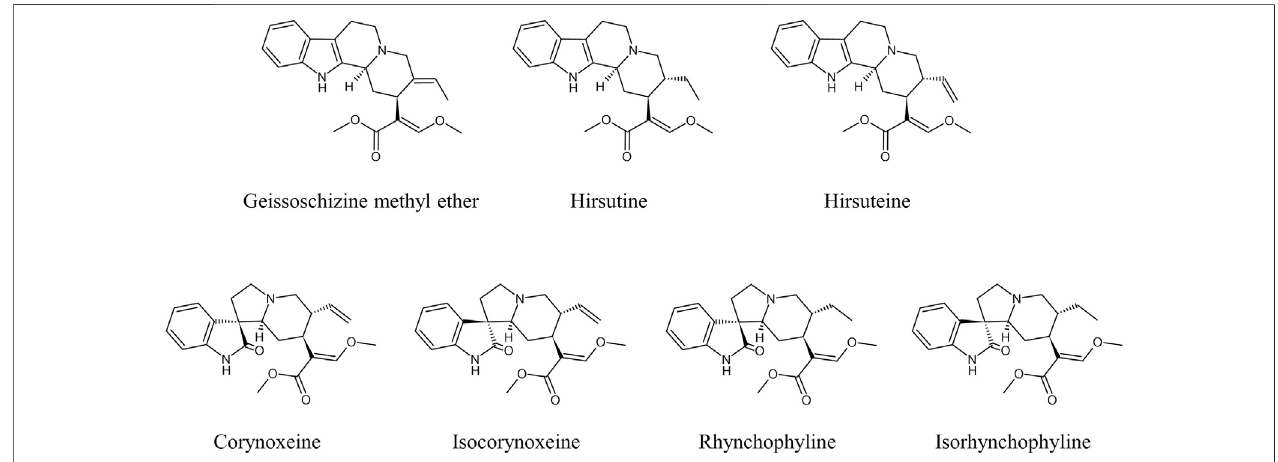
FIGURE 1 | Chemical structure of the main indole and oxindole alkaloids in UH.